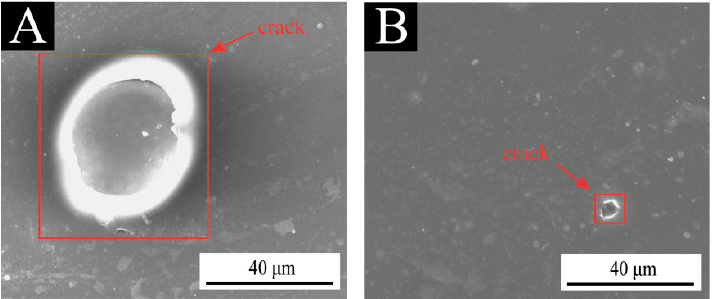
Figure 12. SEM images of coating without and with microcapsules after aging at 120 °C in oven: ( A ) without microcapsules, ( B ) with 6.0% microcapsules.